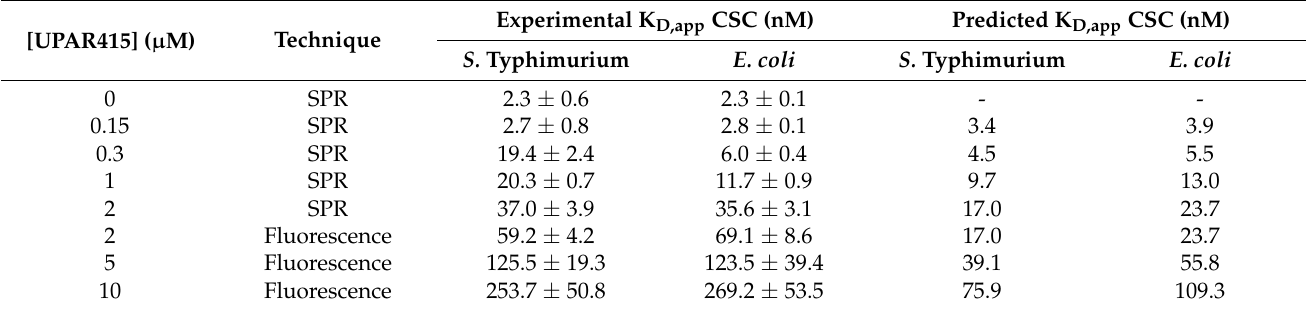
Table 1. Comparison between experimental K D of CS complex (CSC) from S. Typhimurium and E. coli in the presence of UPAR415 and predicted values obtained by Equation (4) (see Materials and Methods). The K D values obtained by SPR measurements in the absence of inhibitor were used to calculate the predicted apparent dissociation constants. Errors are expressed as standard